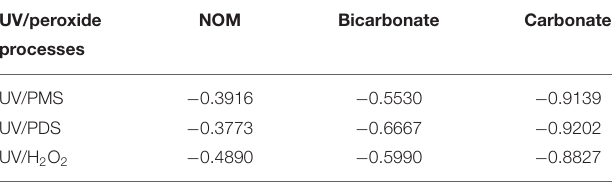
TABLE 2 | Relative differences of k 0 between UV/peroxide processes and UV/peroxide processes in the presence of additives (radical scavengers) ( k 0 ’ – k 0 )/ k 0 .